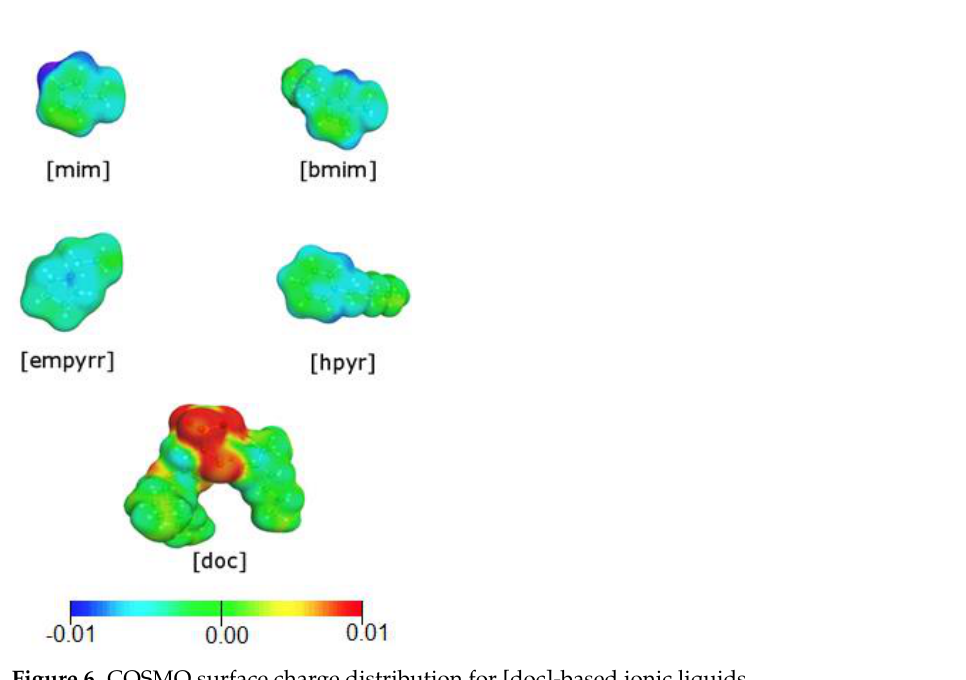
Figure 6. COSMO surface charge distribution for [doc]-based ionic liquids.